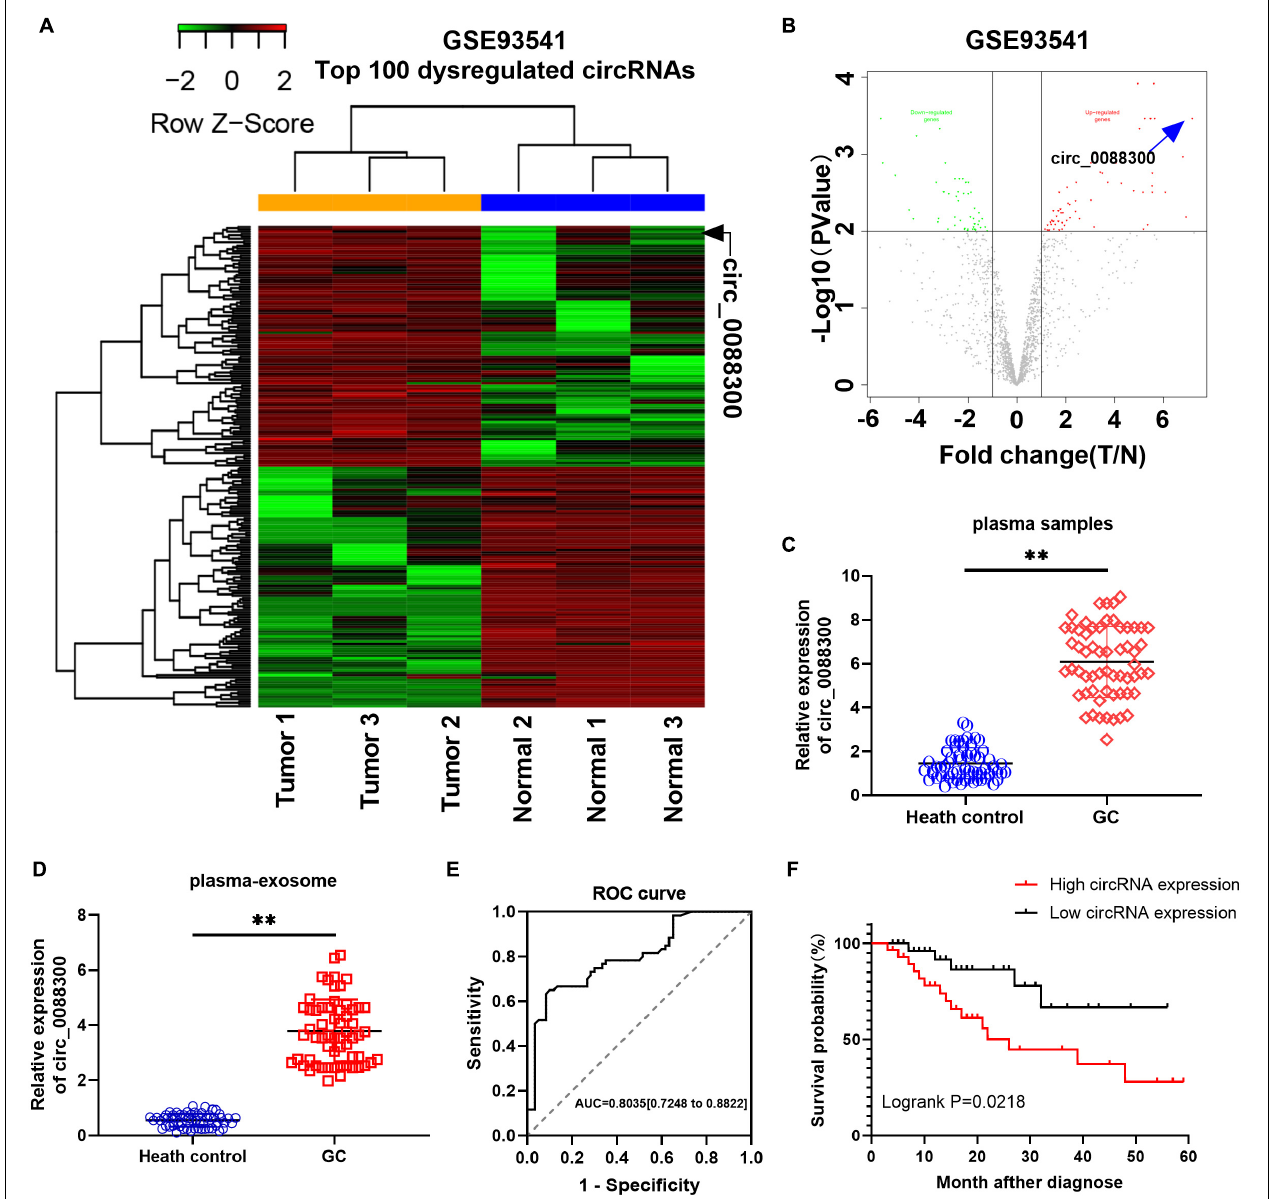
FIGURE 1 | Identificationof circ_0088300 as a GC diagnosis and prognosis biomarker. (A) Heat map showing the top 100 dysregulated circRNAs in the GSE93541 dataset, which are displayed on a scale from green (low) to red (high); data are based on three paired human GC plasma samples and normal controls. The arrow represents the circRNA (hsa_circ_0088300) with the greatest fold changes. (B) Volcano plot map of the dysregulated circRNAs in the GSE93541 dataset, and the arrow represents circ_0088300 with the greatest upregulation in GC cells. (C) The relative expression of circ_0088300 in plasma of 60 GC patients and 60 volunteers. (D) The relative expression of circ_0088300 in exosomes derived from the plasma of 60 GC patients and 60 volunteers. (E) ROC curve of circ_0088300 in GC. (F) Survival curve of GC patients with highexpression ( n = 30) of circ_0088300 or low expression ( n = 30) of circ_0088300 ( ∗∗ P <